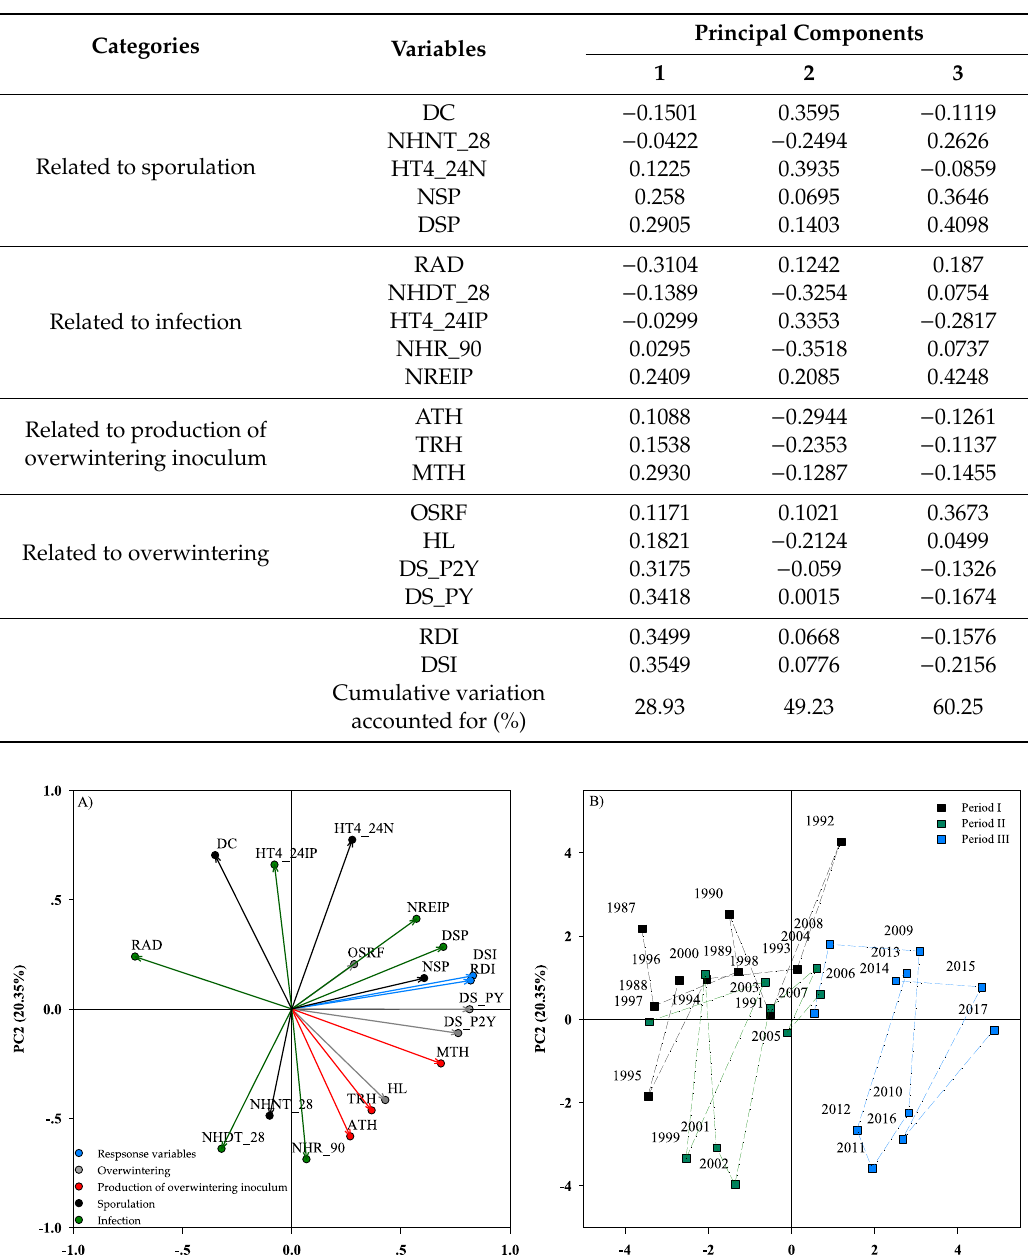
Table 4. Composition of the eigenvectors (as linear combinations of variables) for the first three principal components in the PCA.